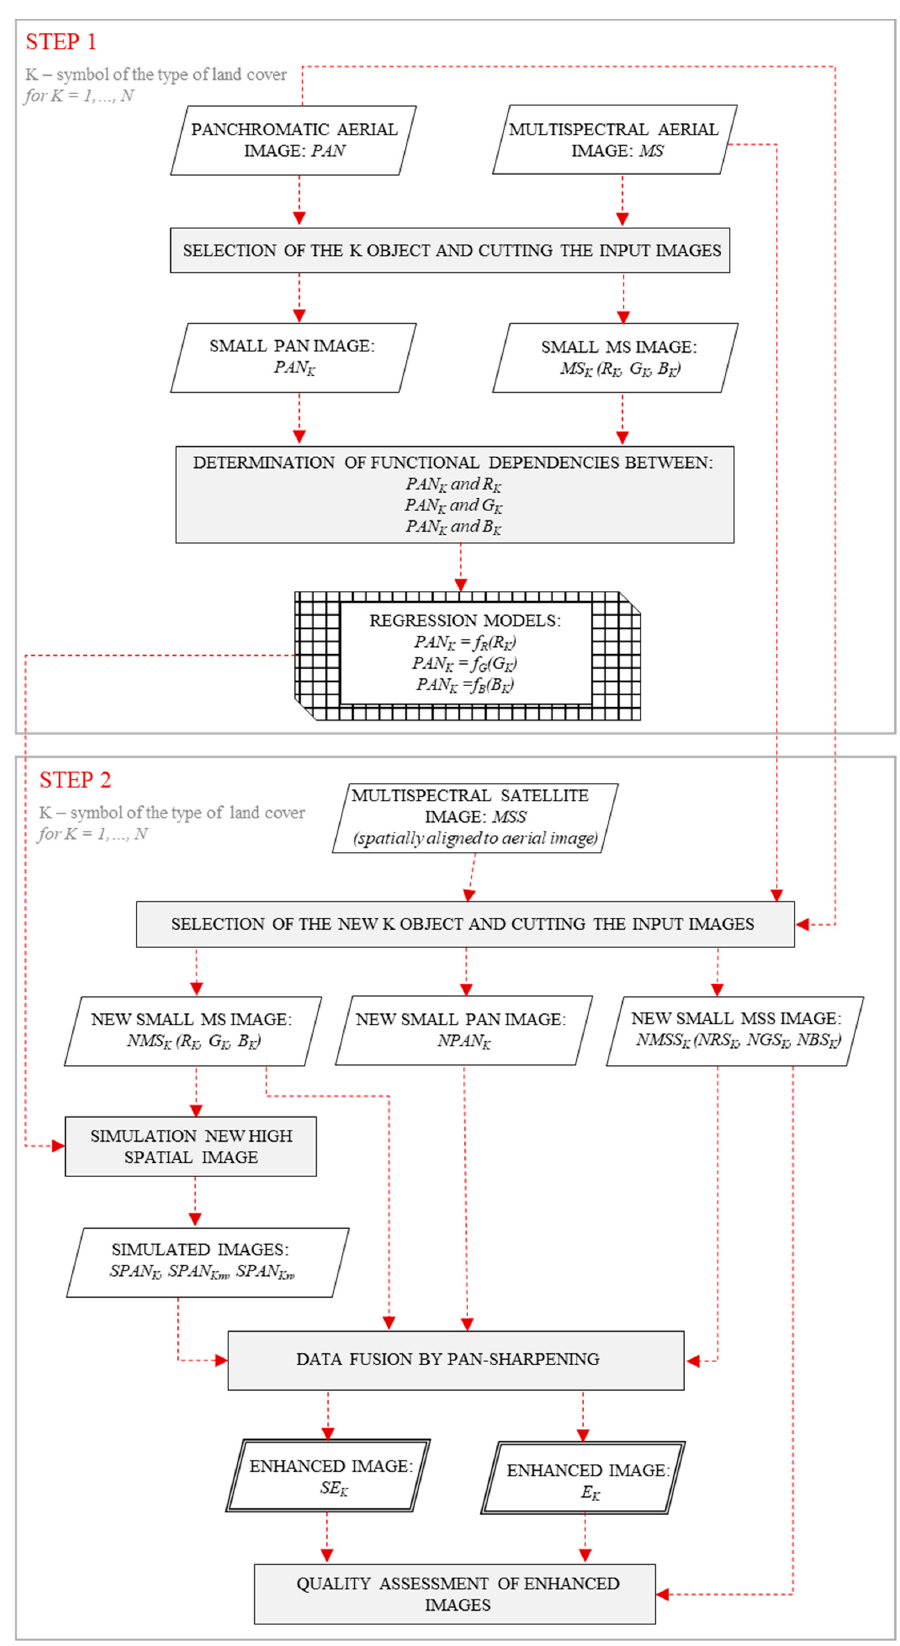
Figure 2. Flowchart for the data fusion.